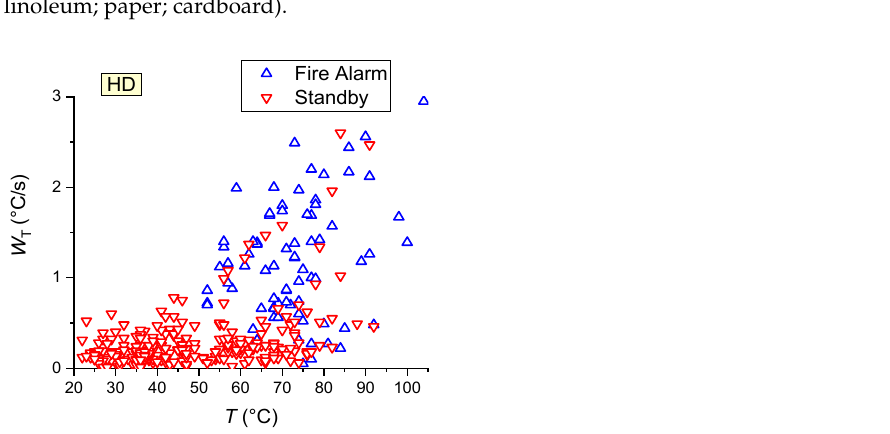
Figure 16. Maps of HD activation/activation failure during the combustion of fuel materials (wood; linoleum; paper; cardboard).